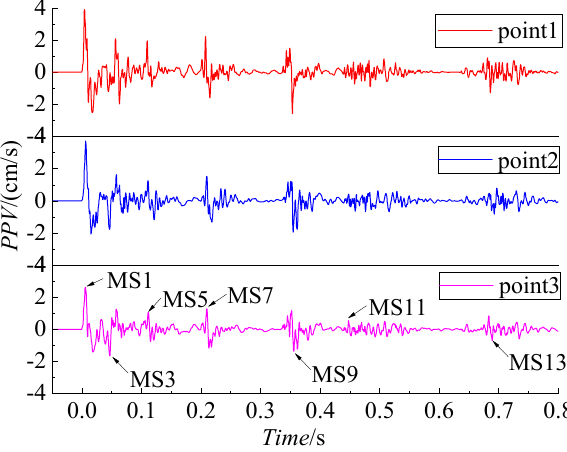
Figure 10. Time history curve of the measuring point.